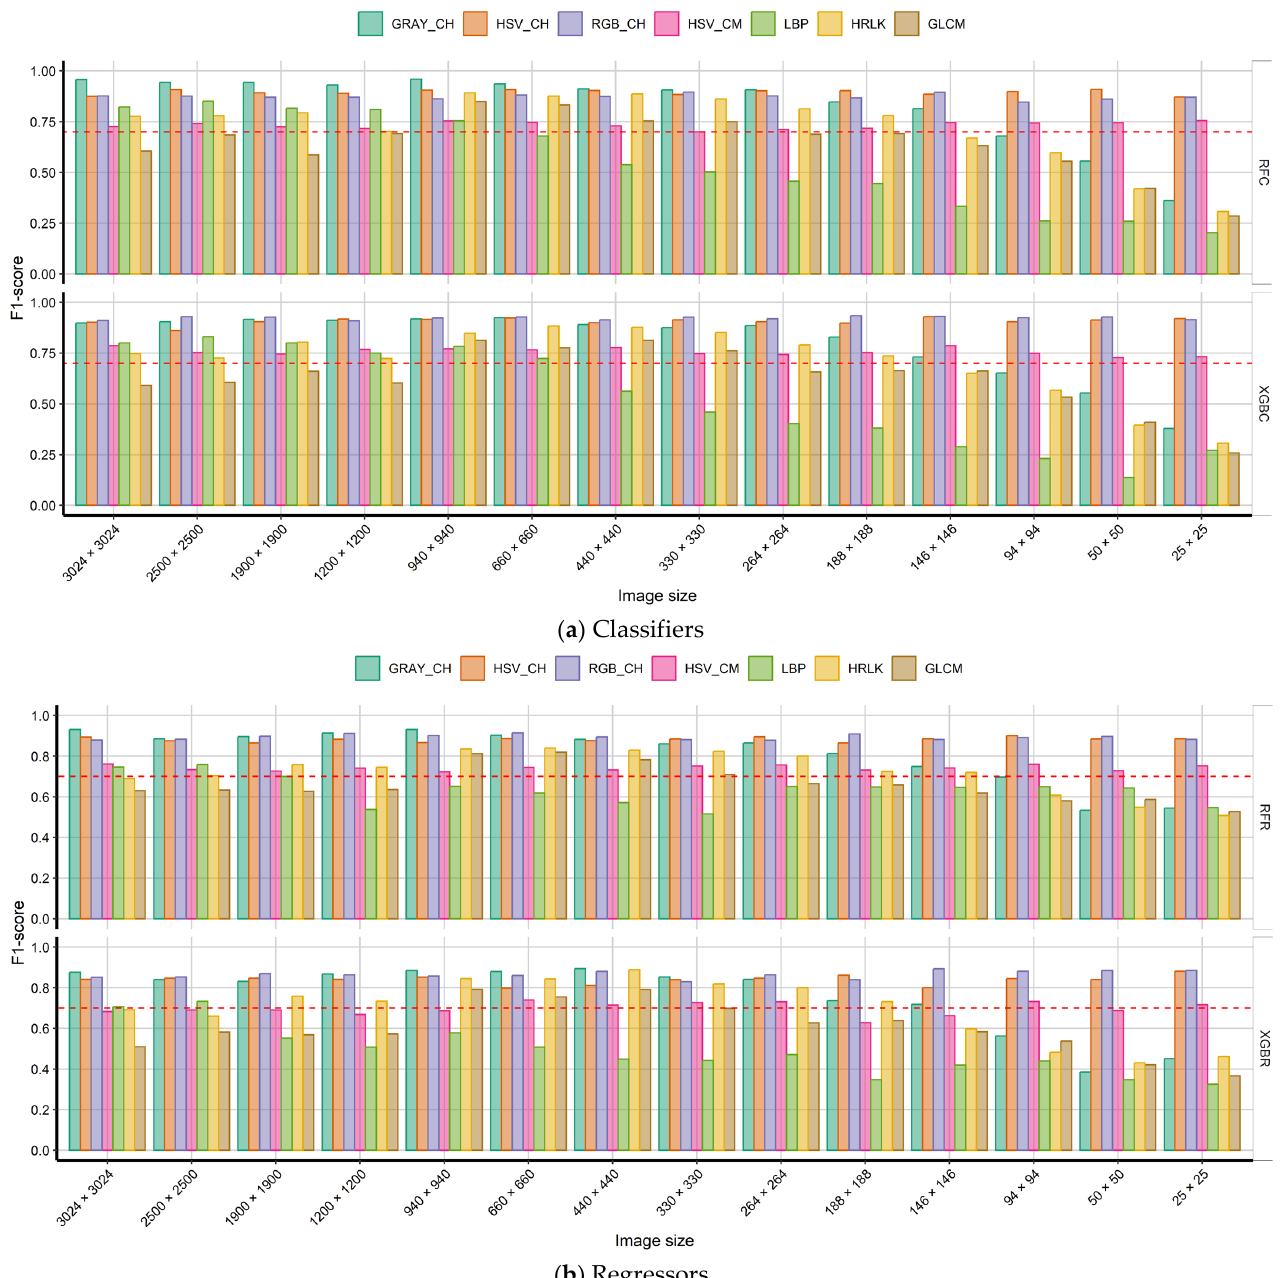
Figure 8. F1-score average performance with global descriptors between classifiers and regressors while cropping the images in dataset G03.